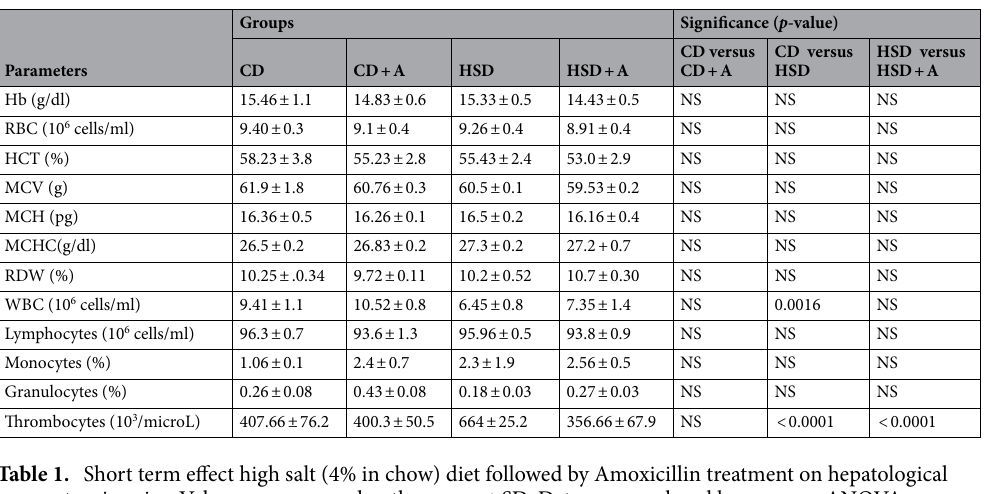
Table 1. Short term effect high salt (4% in chow) diet followed by Amoxicillin treatment on hepatological parameters in mice. Values are expressed as the means ± SD. Data were analyzed by one-way ANOVA, followed by Bonferroni test, n = 6, p ≤ 0.05, NS = Not significant, CD: Standard—chow diet for 3 weeks; CD + A: Standard—chow diet for 3 weeks and subjected Amoxicillin treatment in 3rd week; HSD: High-salt diet for 3 weeks; HSD + A: High-salt diet for 3 weeks and subjected to Amoxicillin treatment in 3rd